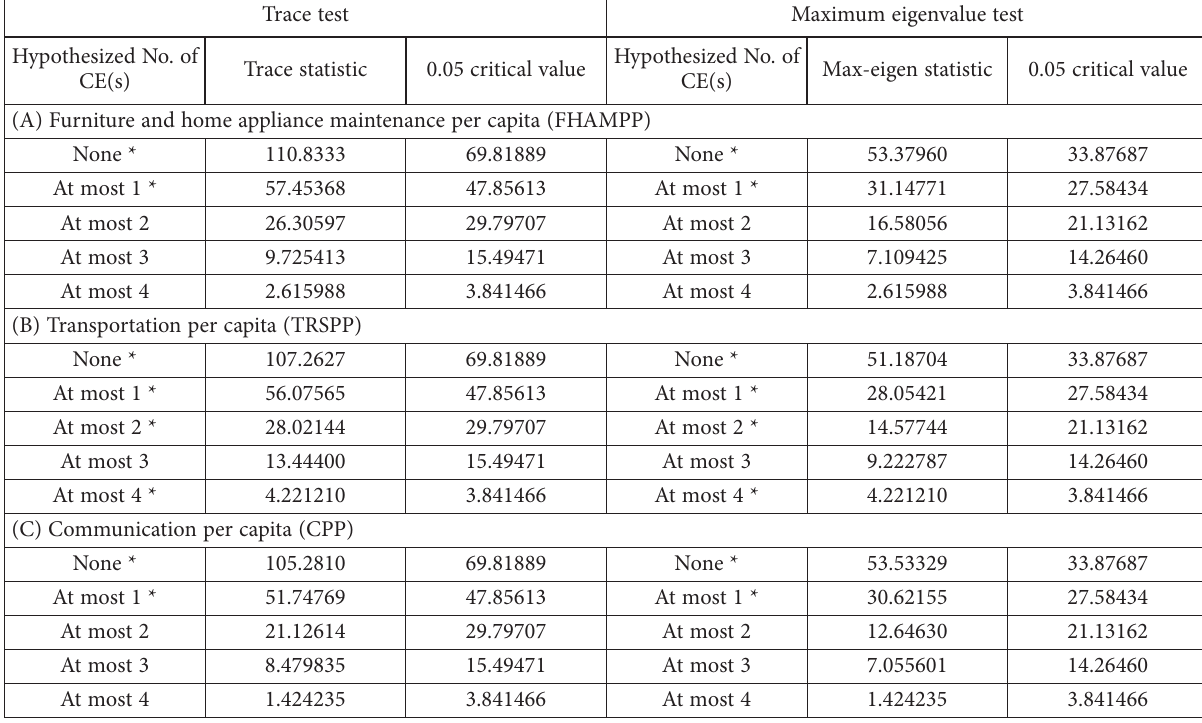
Table 6. Johansen test for cointegration on sub-categories of durable goods consumption Trace test